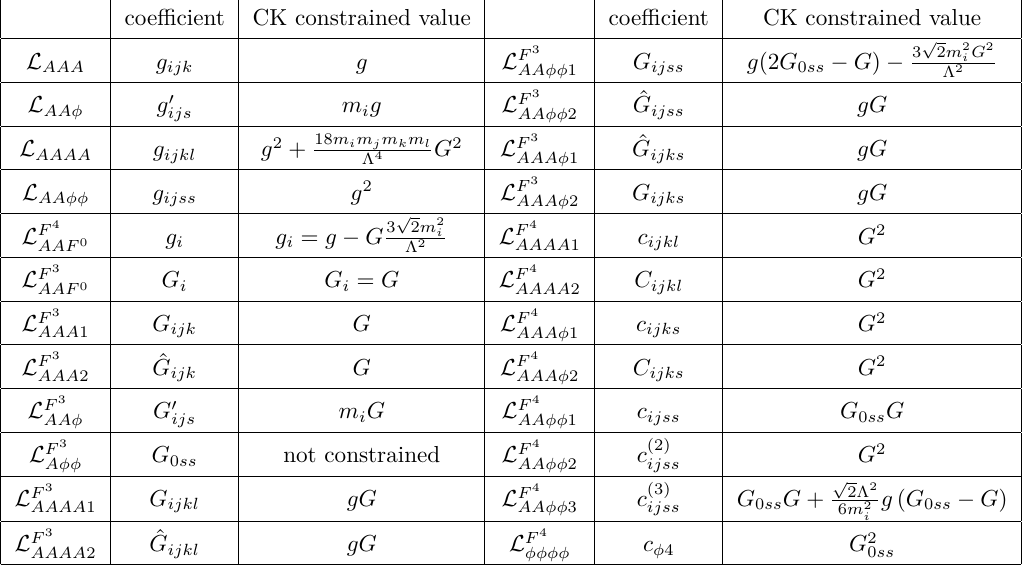
Table 2 . Coefficients of the interactions constrained by the demands of colour-kinematics duality. Summary of